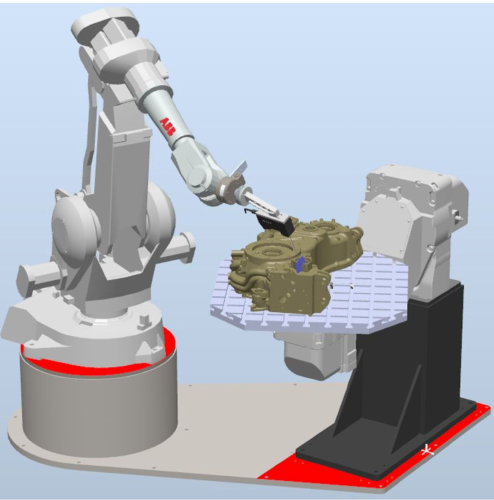
Figure 5. Inspection workstation’s model in